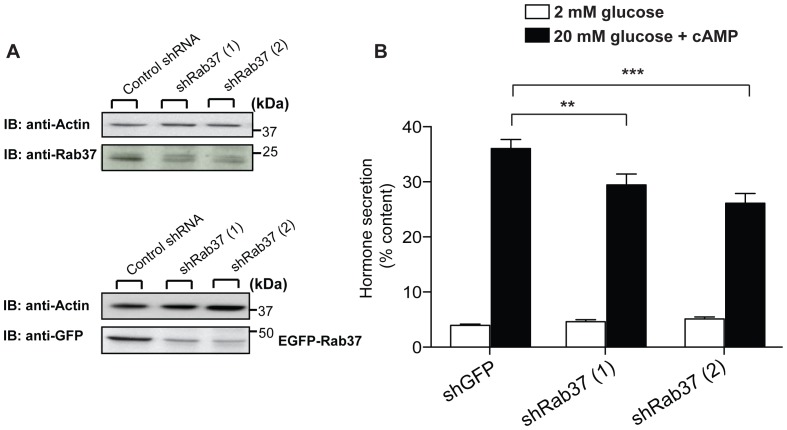
Rab37 knock-down impairs hormone secretion induced by secretagogues.
A. The level of endogenous Rab37 (upper panel) and exogenously expressed Rab37-EGFP (lower panel) were estimated by immunoblotting in cells transfected with control shRNA, shRab37 (1) or (2). Equal loading of the lanes was verified using an antibody against actin. B. To assess hormone release, the cells were transiently co-transfected with a plasmid encoding the human growth hormone and with plasmids driving the expression of shRNAs against GFP (control) or with two different shRNAs against Rab37 (shRab37 (1) or (2)). Three days later, the cells were tested for hormone release. For this, they were maintained at 2 mM glucose, (open bars) and then incubated in stimulating solutions (filled bars) containing 20 mM glucose and the cAMP-raising agents Forskolin and IBMX. The amount of hGH expressed by the cells and released in the medium was quantified by ELISA. Hormone secretion under basal and stimulatory conditions is given as % of hGH cellular content. The results are the means of five independent experiments ± SEM. ** p<0.01, *** p<0.001. One-way ANOVA.